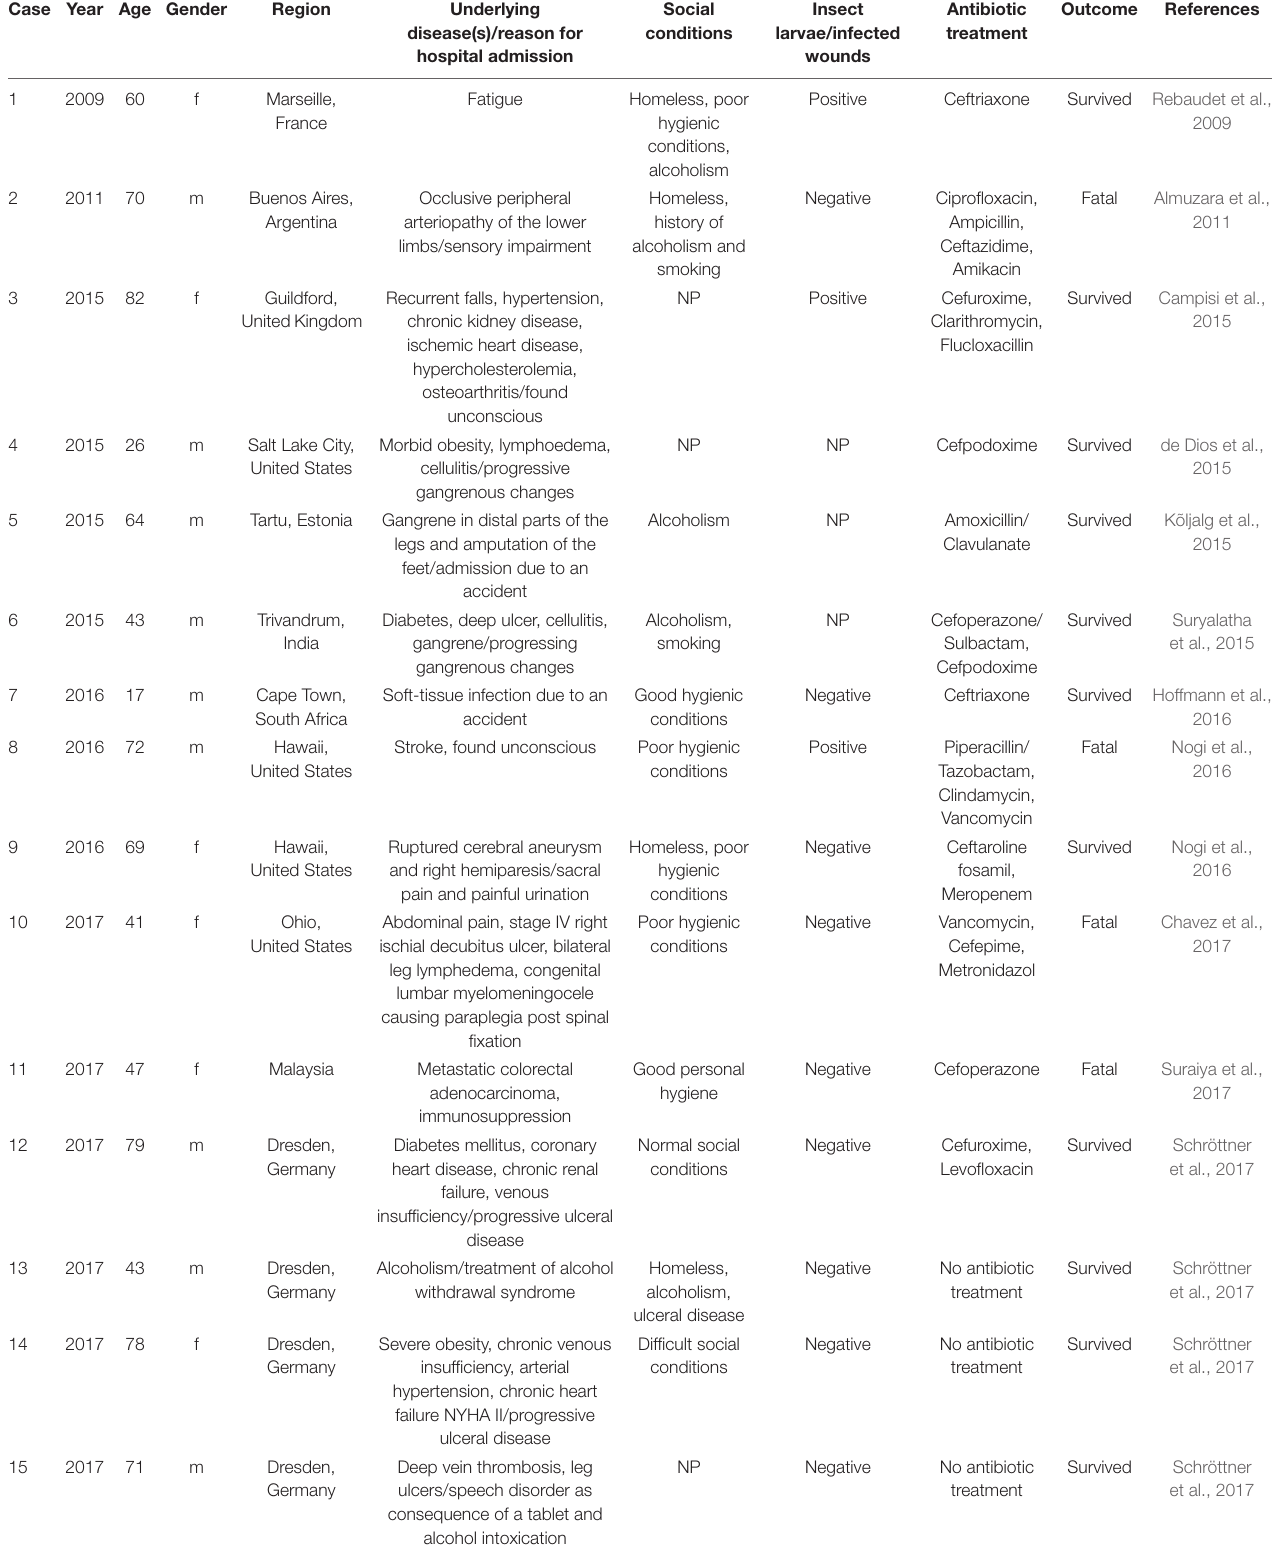
TABLE 1 | Current overview of cases of human infection and colonization with W. chitiniclastica. Case Year Age